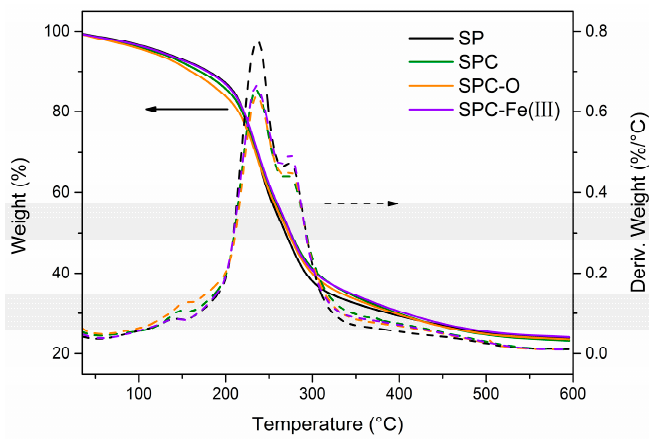
Figure 6. Thermogravimetric (TG) and derivative thermogravimetric (DTG) curves of control and soy-based composite films.